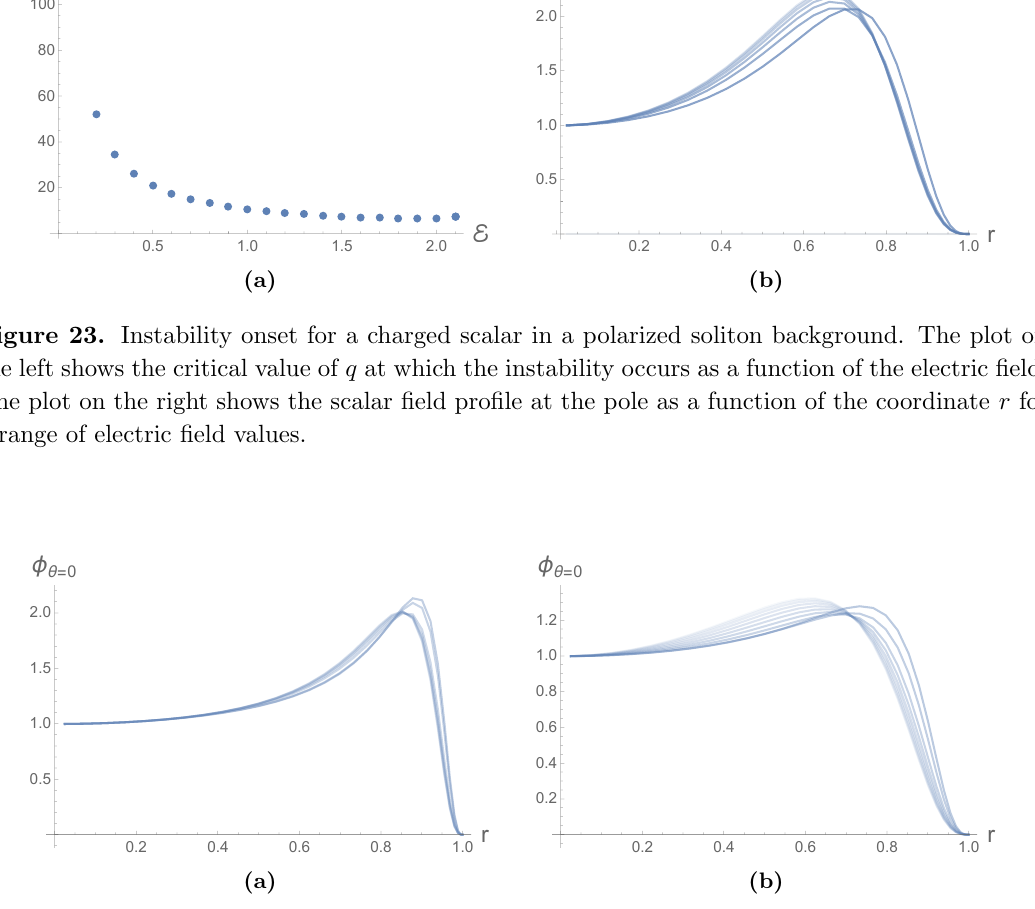
Figure 24. Instability onset for a charged scalar in a polarized black hole background with a temperature T = 1 =(cid:25) for a range of electric (cid:12)eld values. The curves get taller and fainter as the electric (cid:12)eld decreases. The left and right plots show the scalar (cid:12)eld pro(cid:12)les at the pole as a function of r for the small and large black holes,